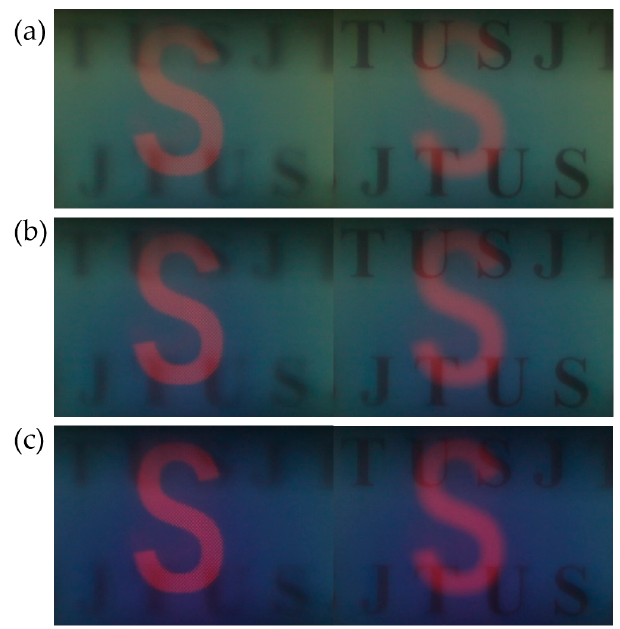
Figure 8. Photos focused on the virtual-information image and the background, respectively, at different voltages ( a ) 1.68 V rms , ( b ) 1.80 V rms , and ( c ) 1.96 V rms .